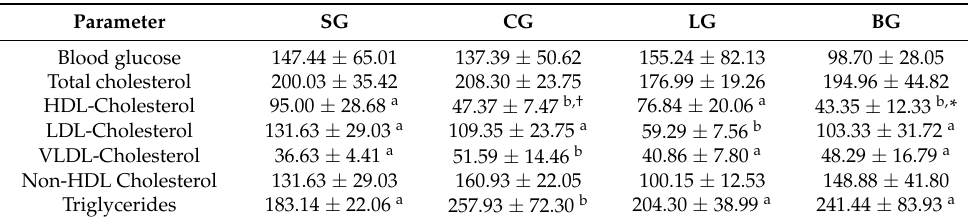
Table 2. Biochemical parameters of the animals treated with certain diets for 60 days, except for lipid sources, with diets containing different vegetable